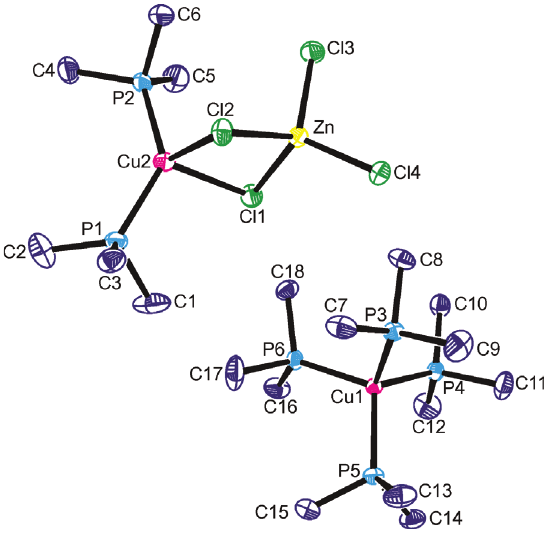
Figure 3 The asymmetric unit of 3 showing the labeling scheme used. Thermal ellipsoids are at the 40% probability level; hydrogen atoms have been omitted for clarity. Selected geometric data: Zn-Cl(1) 2.3266(6), Zn-Cl(2) 2.3397(7), Zn-Cl(3) 2.2458(7), Zn-Cl(4)